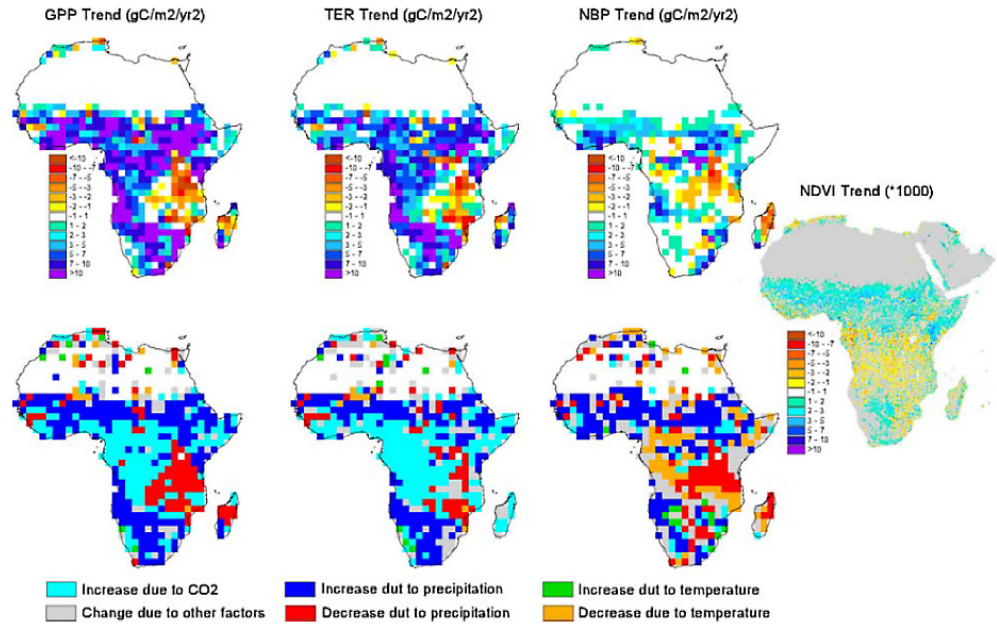
Fig. 8. Spatial distributions of ORCHIDEE modeled trends in annual GPP, TER, and NBP from 1980 to 2002 and of their main driving factor. Reproduced with permission from Ciais et al.